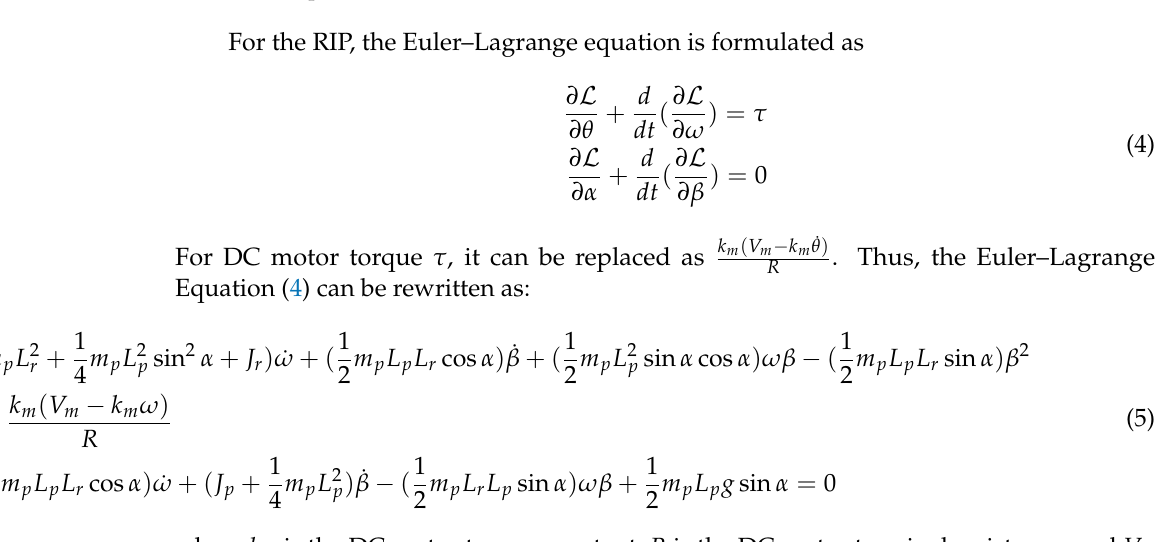
Figure 1. Simplified schematic model of the